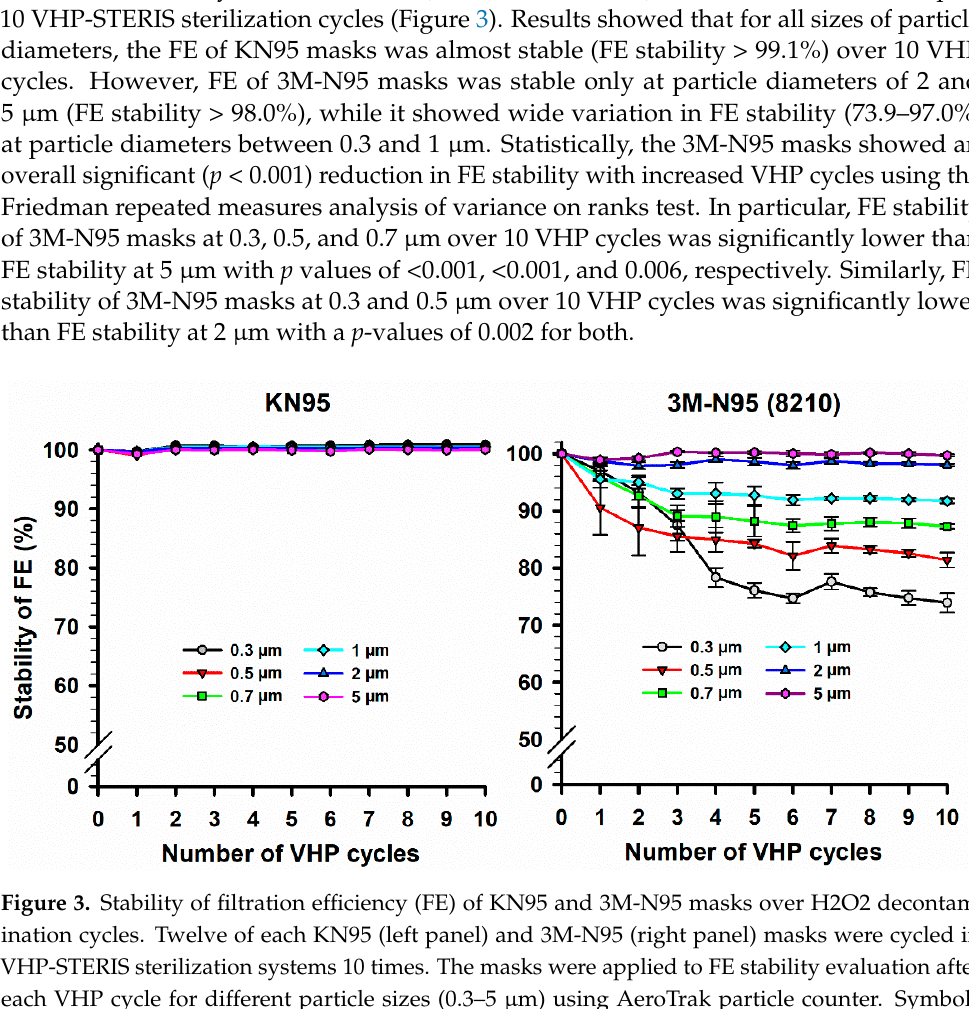
6 of 12 Figure 2. Filtration efficiency (FE) of different types of FFRs. Seven types of FFRs were applied to FE evaluation for different particle sizes (0.3–5 µm) using AeroTrak particle counter; KN95 (moulded shape, n = 10), 3M-1820 (n = 10), Gerson-1730 (n = 5), Medline (n = 5), Benehal (n = 5),